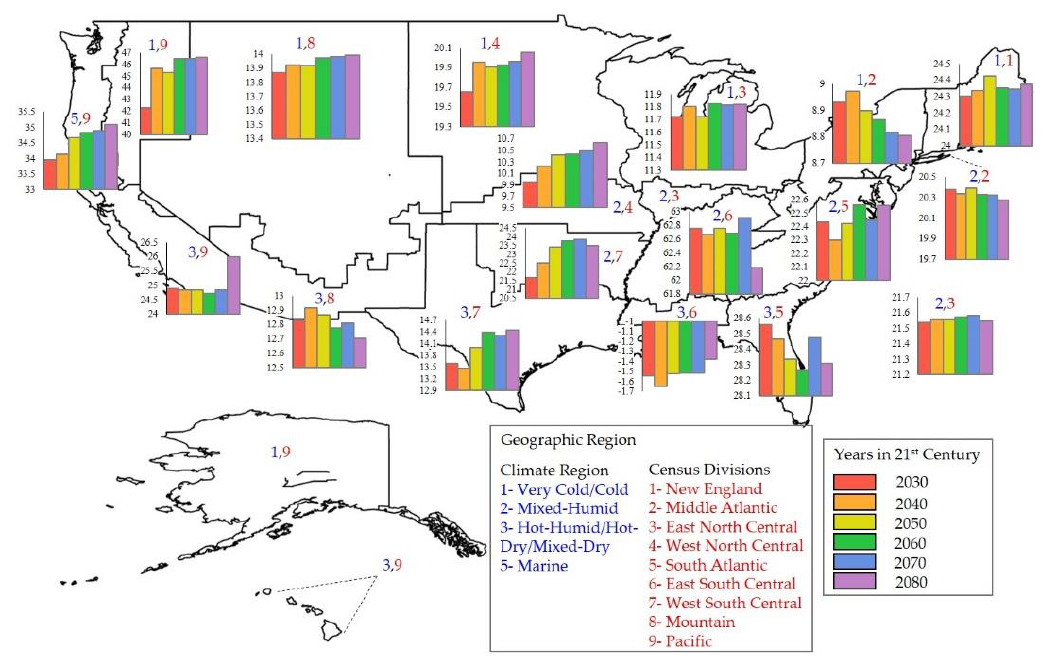
Figure 6. Change in EUI (%) compared to 2012 EUI of office buildings under RCP8.5 during the 21st century for different geographic regions. Note: Y-axes change per geographic region.